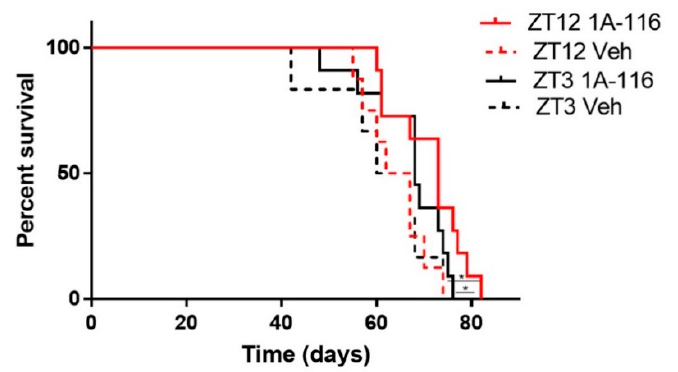
Figure 5. GBM bearing nude mice treated with 1A-116 at ZT12 exhibited increased survival rates than mice treated with 1A-116 at ZT3. Survival curves of nude mice treated with vehicle or 1A-116 in ZT3 and ZT12 were significantly different ( n = 11, Mantel–Cox log rank Test, * p < 0.05). Median survival increased in ZT12. The median survival times obtained from fitting the data are listed: ZT12 Veh: 64.5 days, ZT3 Veh: 63.5, ZT12 1A-116: 73 days, ZT3 1A-116: 68 days.